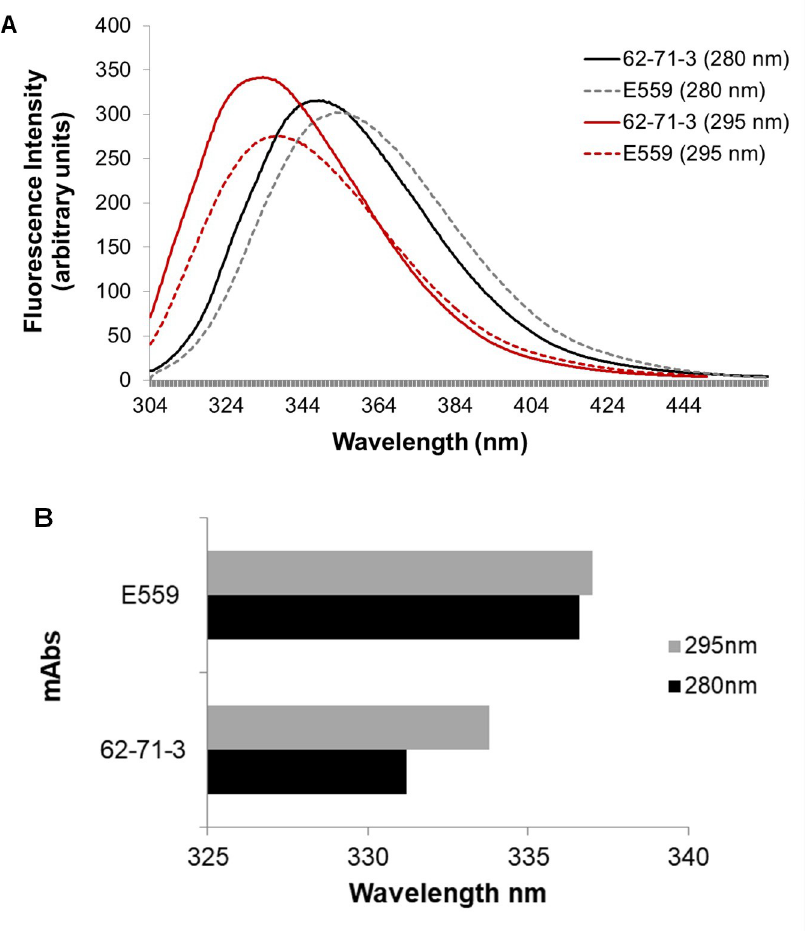
Fig 2. Intrinsic fluorescence emission spectra of native E559 and 62-71-3 excited at 280 nm. Graph A shows the fluorescence emission spectra of E559 (excited at 280 nm: dotted grey line; excited at 295 nm: dotted red line) and 62- 71-3 (excited at 280 nm: black solid line; excited at 295 nm: solid red line). The spectra are averages of three accumulations. Graph B illustrates the shift in wavelength between both mAbs. The maximum emission wavelength (280 nm: black bar and 295 nm: grey bar) for 62-71-3 and E559.